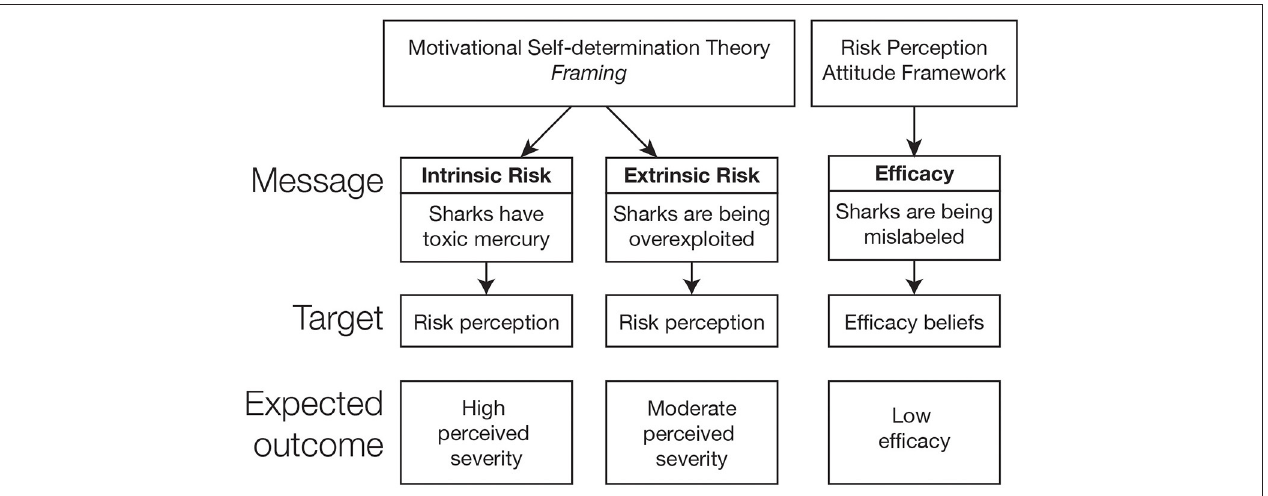
FIGURE 1 | Theoretical framework. Theoretical framework showing the targets of the experimental messages and the predicted changes in the perceived states.